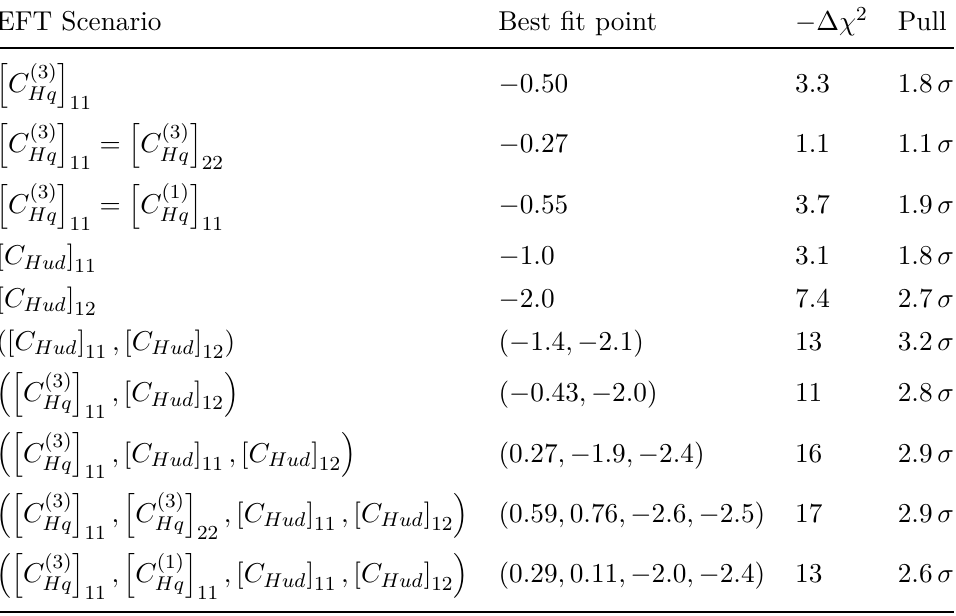
Table 4 . Best fit points, ∆ χ 2 and pulls w.r.t. the SM hypothesis for the various EFT scenarios. The best fit points are in units of 10 − 3 v − 2